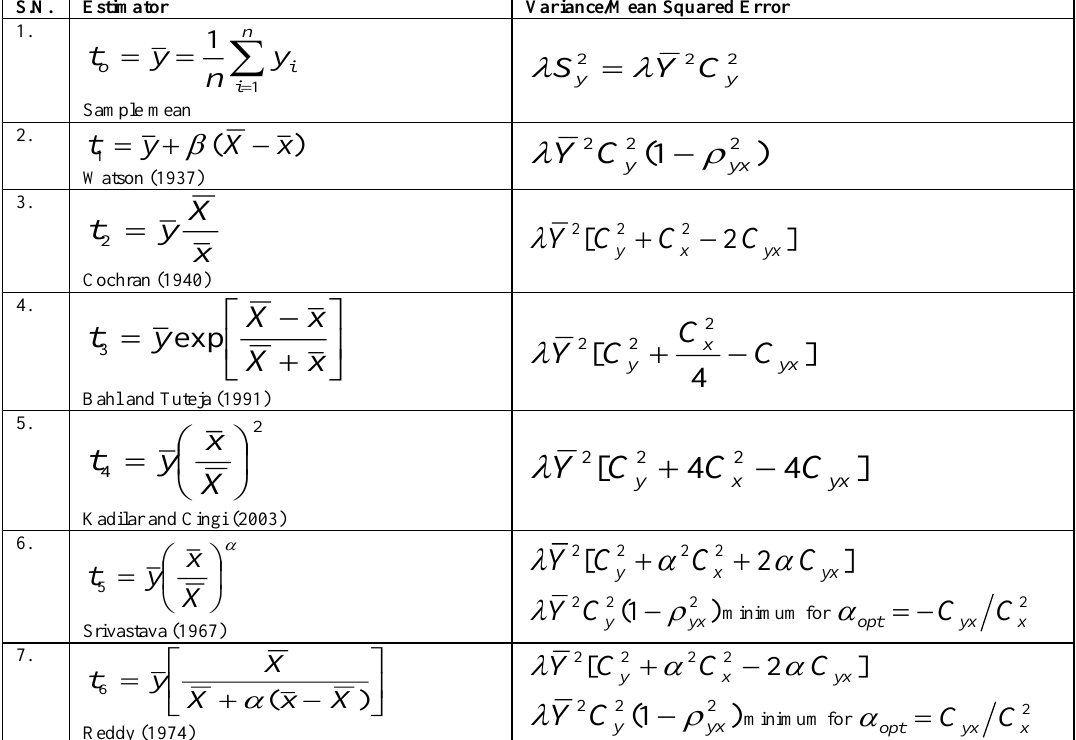
Table1. Various estimators of population mean along with their mean squared errors S.N. Estimator Variance/Mean Squared Error